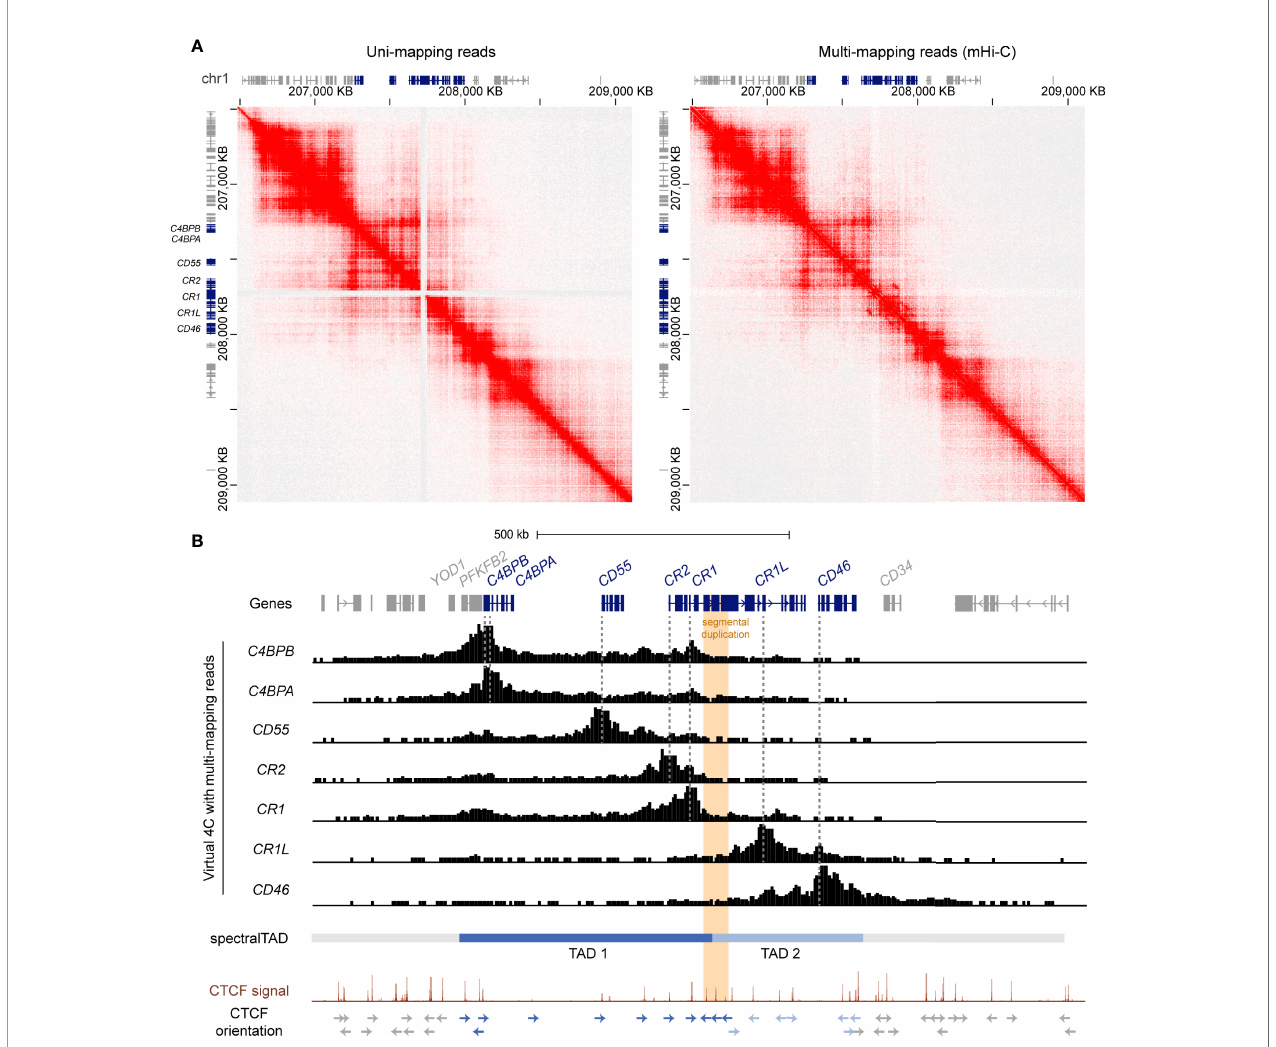
FIGURE 2 | The RCA gene cluster is divided into two TADs and the inter-TAD boundary is located at the CR1 segmental duplication. (A) Hi-C contact maps of GM12878 data at 5 kb resolution from Rao et al. (44) with only uni-mapping reads and both uni- (left panel) and multi-mapping (right panel) reads assigned with mHi-C. Using mHi-C, interactions across the CR1 segmental duplication were successfully recovered. Data was visualised using Juicebox. (B) mHi-C interactions were visualised as virtual 4C signal from the promoters of the RCA genes, which showed that interactions of RCA genes were constrained to two distinct regions. SpectralTAD was used to call TADs using Hi-C data with multi-mapping reads recovered, de fi ning two clear TADs in the RCA cluster. Raw GM12878 CTCF ChIP- seq signal from ENCODE showed enrichment of convergent CTCF at the boundaries of both TADs and revealed that the CR1 segmental duplication (orange) is fl anked by repeated reverse orientation CTCF sites (indicated by